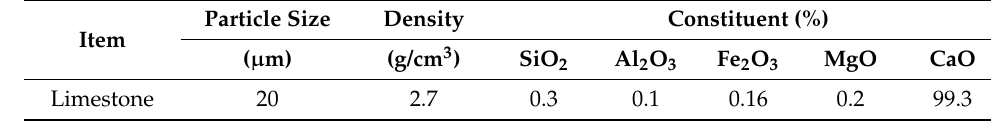
Table 1. Analysis of limestone components.